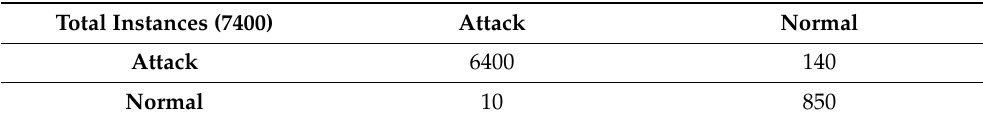
Table 9. Testing confusion matrix of KNN.